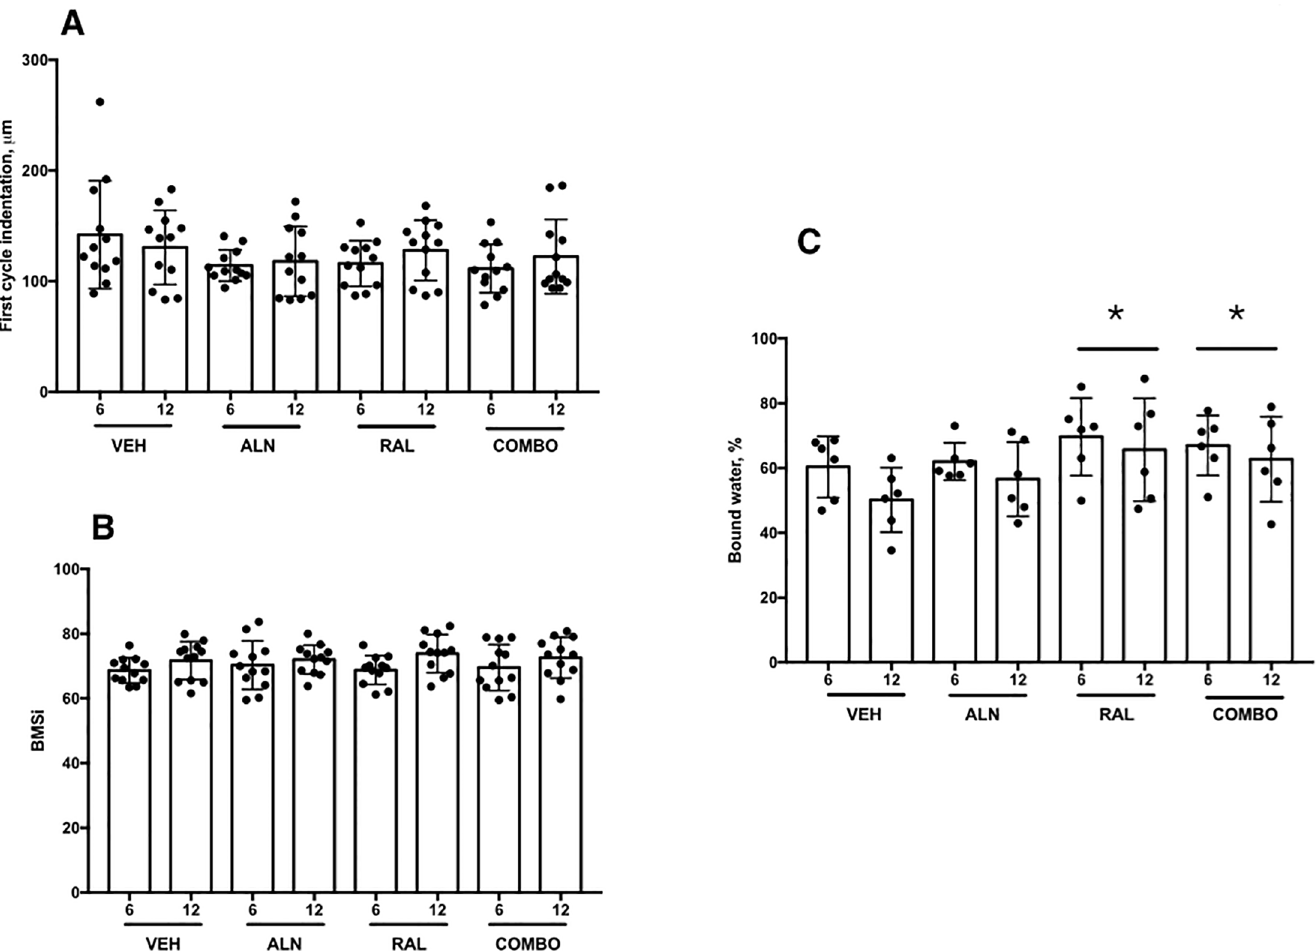
Fig 2. In vivo assessments after 6 and 12 months of treatments among the groups. (A) First cycle indentation depth from BioDentcyclic indentation device showedsignificantgroup effects but no effect of time or interaction between group and time. (B) Bone material strength index (BMSi) from Osteoprobe impact testing showedno significanteffect of treatment or time. (C) Bound water from UTE-MRI measuresof the proximal tibia showing higherpercentages in raloxifene and combination treatments relative to vehicles. Gray bars represent 6 months; Black bars represent 12 months. * p < 0.05 when pooledacross groups relativeto VEH